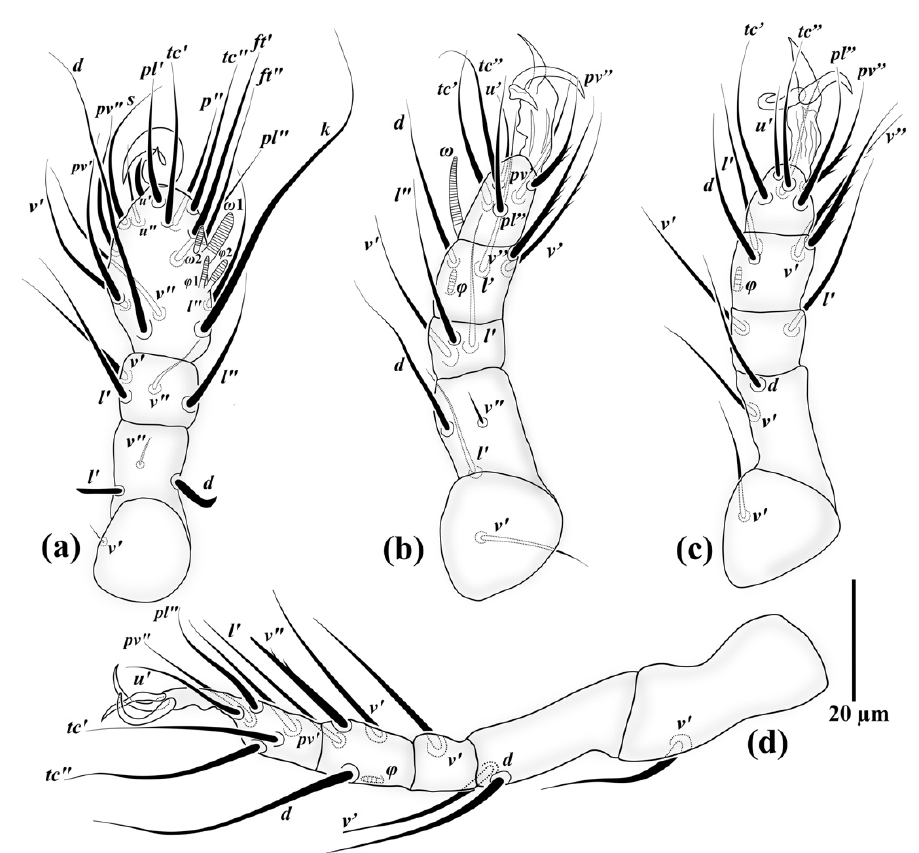
Figure 3. Right legs of Allopygmephorus coelostomus sp. nov . ( a ) leg I; ( b ) leg II; ( c ) leg III; ( d ) leg IV.